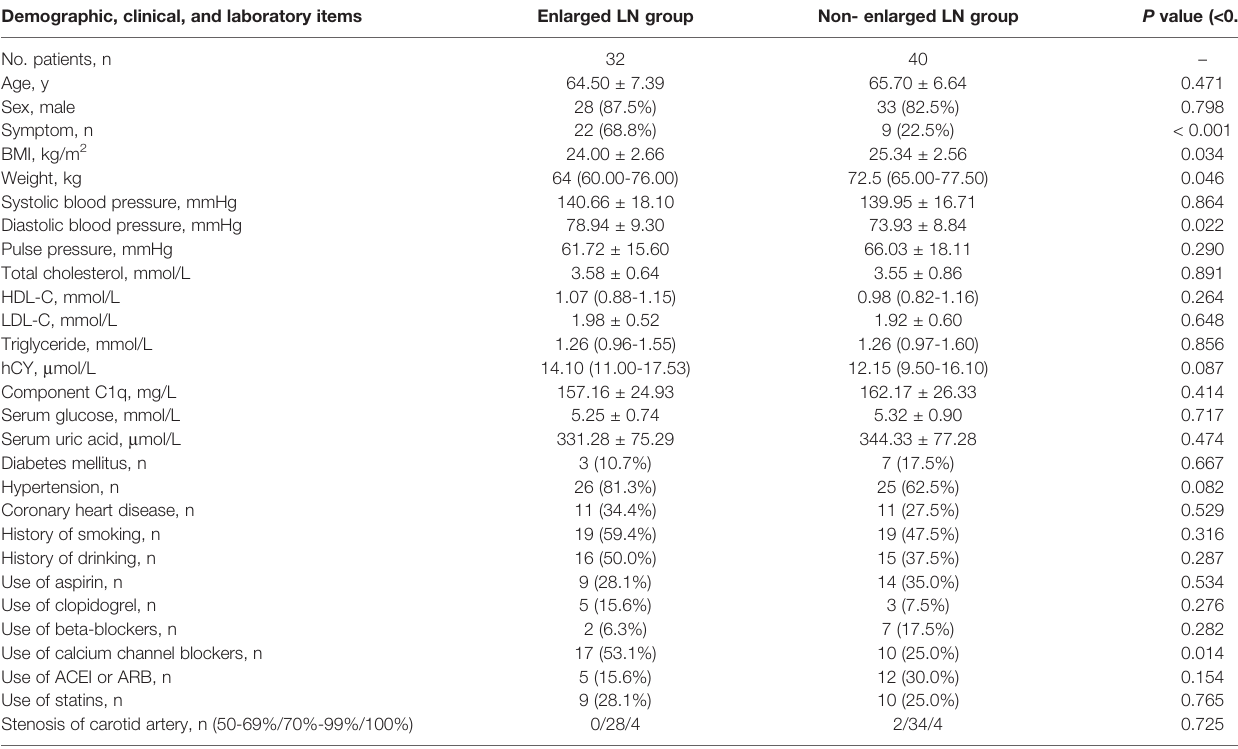
TABLE 1 | Baseline Characteristics of Study